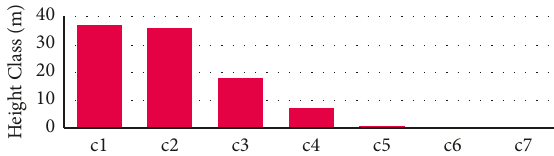
Figure 3: Frequency distribution of trees and shrubs in height